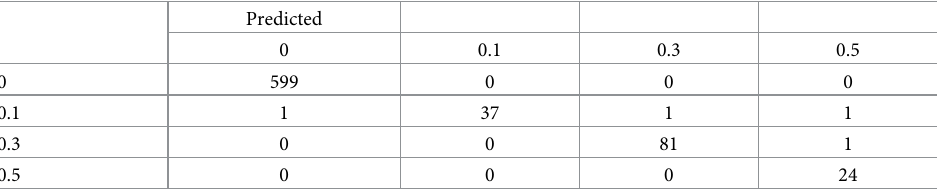
Table 6. Multinomial logistic regression on spectral data obtained from C3H/HeJ mice only. Data was classified based on degree of fibrosis (regional pathology grades). Predicted